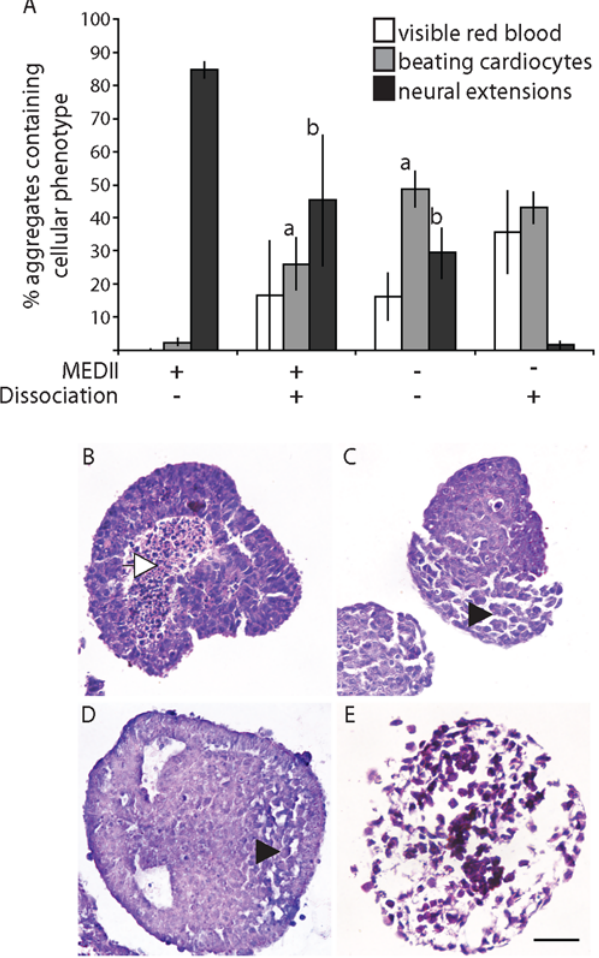
Figure 1. Cell dissociation and MEDII both impact on lineage choice during EPL cell differentiation. ( A ). EPL cells were formed in aggregates in MEDII for three days before being dissociated and reaggregated in unsupplemented tissue culture medium or medium supplemented with 50% MEDII (MEDII + ). Alternatively, EPL cells were maintained in aggregates and transferred to unsupplemented tissue culture medium or medium supplemented with 50% MEDII. Aggregates were maintained for a further 4 days (to day 7) in suspension culture before being seeded individually into 48 tissue culture wells in unsupplemented medium and allowed to differentiate. Aggregates were scored for the presence of visible red blood cells, beating cardiocytes and neural extensions and the peak score for each represented. n $ 3 independent experiments. Error bars represent standard error of the mean (sem). (a) denotes an increase compared to MEDII + /Dissociation 2 where p , 0.01. (b) denotes an increase compared to MEDII 2 /Dissociation + where p , 0.05. ( B–D ). Aggregates cultured as for A were collected and fixed on day 7 before paraffin embedding and sectioning. Sections were stained with haemotoxylin/ eosin and viewed with a Ziess Axiophot microscope. ( B ). MEDII + /Dis 2 EB. ( C ). MEDII + /Dis + EB. ( D ). MEDII 2 /Dis 2 EB. ( E ). MEDII 2 /Dis + EB. Scale bar represents 50 m m. The white arrowhead in B indicates an area of cell necrosis. The black arrowheads in C and D denote areas of cell morphology similar to that found in E.